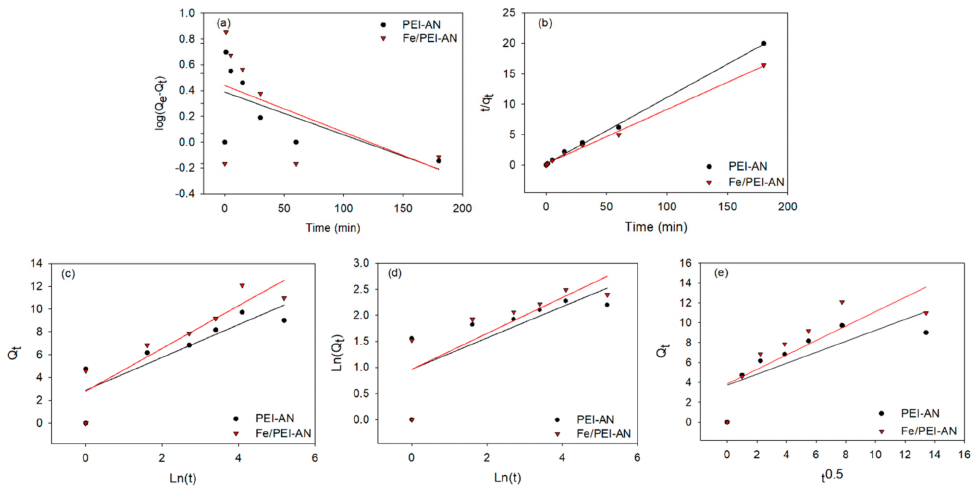
Figure 5. Plotted kinetic models: ( a ) PFO, ( b ) PSO, ( c ) Elovich, ( d ) Power function and ( e ) intraparti- cle diffusion. Table 3. Calculated parameters of kinetic